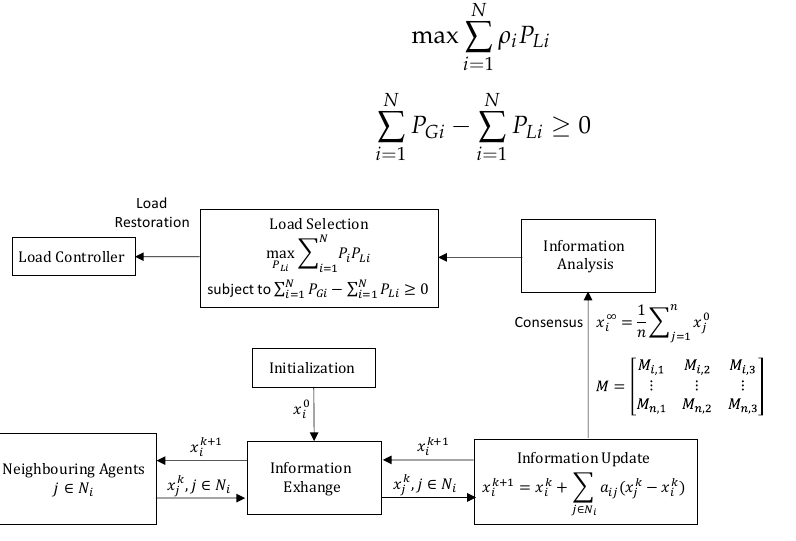
Figure 11. Cooperative load restoration in [125].